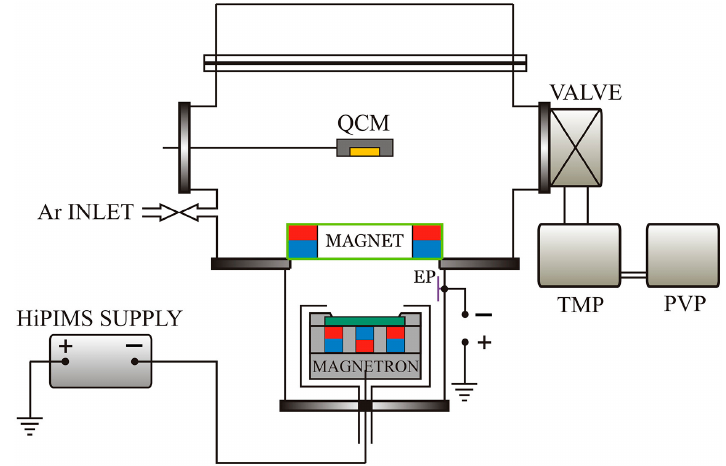
Figure 8. Schematic drawing of the experimental setup used in the work. Reproduced from [99] with permission. Copyright 2018 Elsevier.